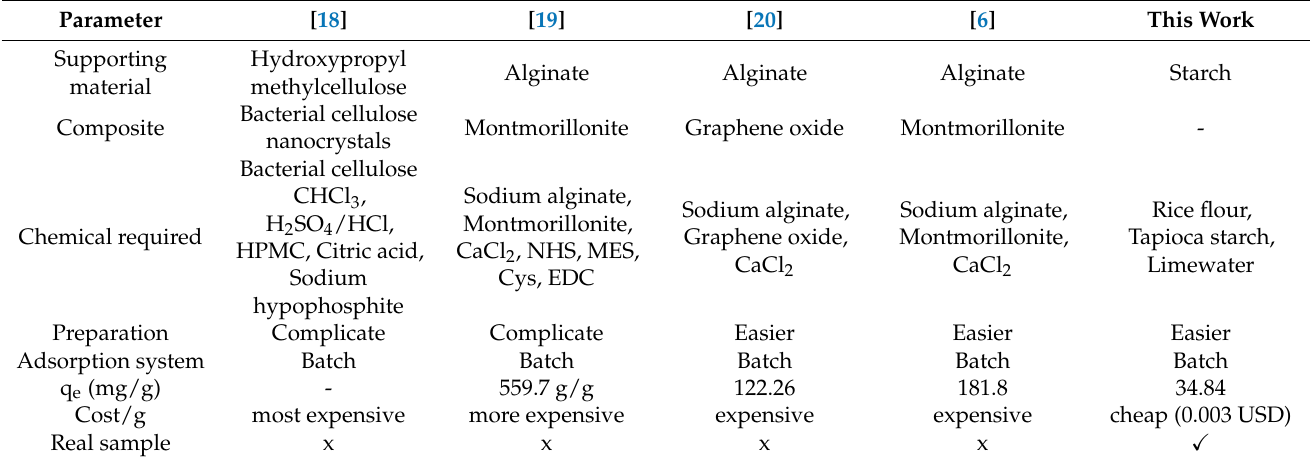
Table 4. Comparison of various parameters of starch cryogel and other cryogel materials for MB